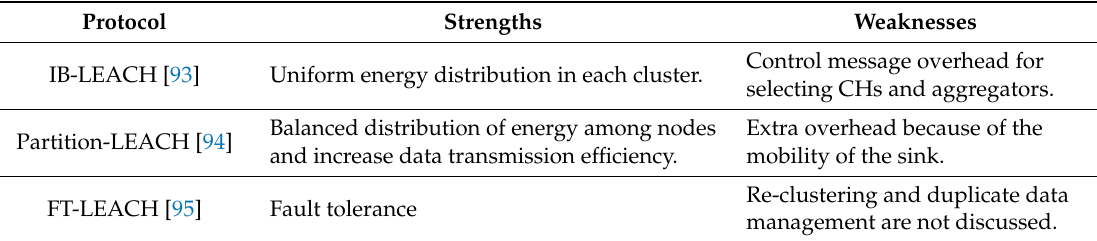
Table 7. Summary of energy efficiency-based cluster formation